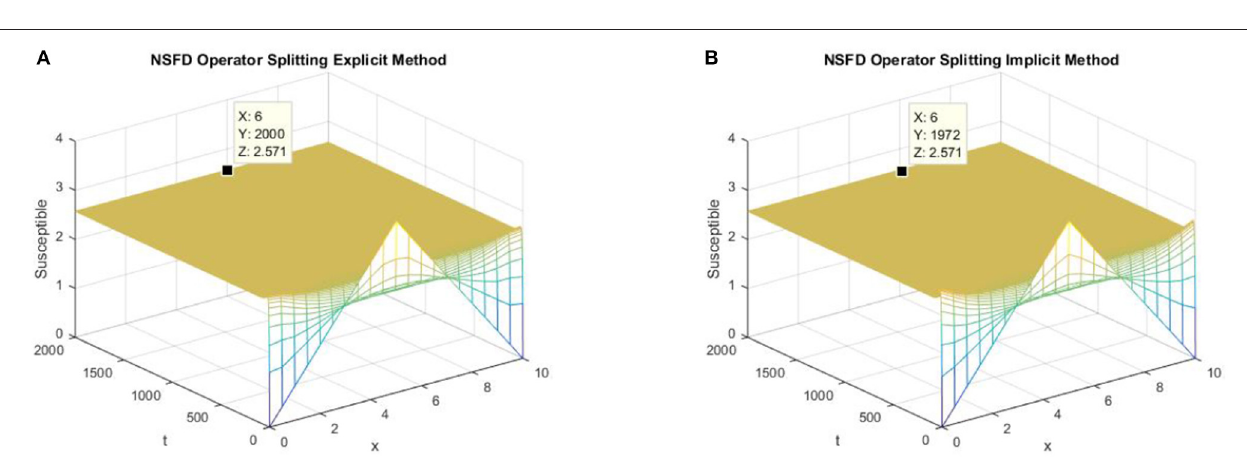
Frontiers in Physics |